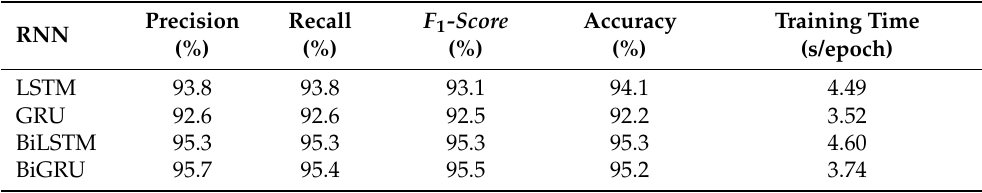
Table 2. The performances of the feature-extraction models with LSTM, GRU, BiLSTM, and BiGRU, separately.